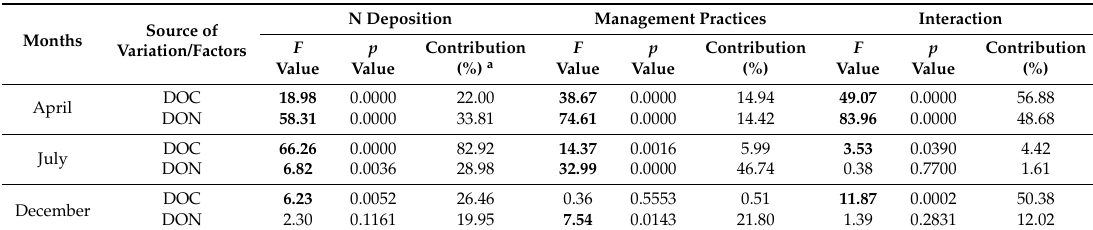
Significant contribution at p < 0.05 or p < 0.01 is shown in bold. a The contribution (%) is the percentage of overall variance explained by each factor.